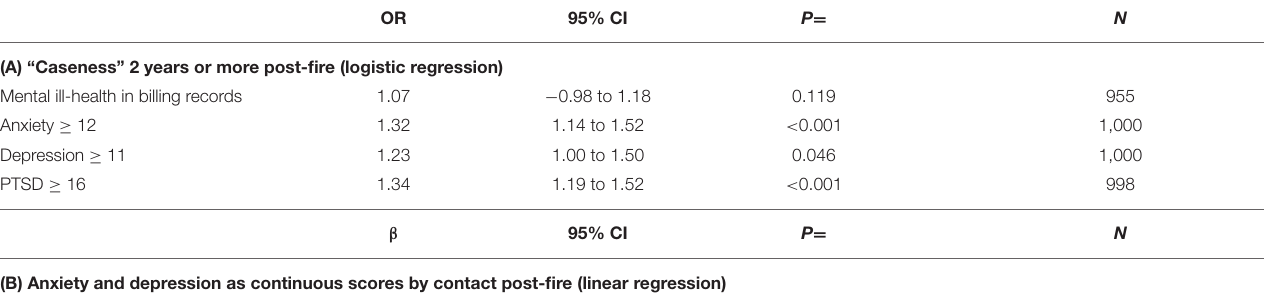
TABLE 5 | Bivariate relation of particulate exposure during the fire to mental health post-fire. OR 95% CI P =